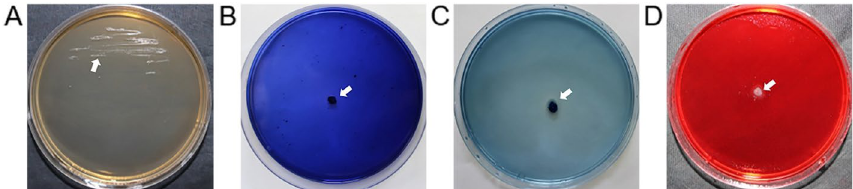
Fig. 5 A Pseudomonas sp. (NH.W1-B1) could grow on the sodium lignosulfonate agar medium. B Decolorizing circles of Pseudomonas sp. (NH. W1-B1) grown on the aniline blue agar medium for 5 days. C Decolorizing circles of Pseudomonas sp. (NH.W1-B1) grown on the remazol brilliant blue agar medium for 5 days. D Decolorizing circles of Pseudomonas sp. (NH.W1-B1) grown on the CMC-Na agar medium for 5